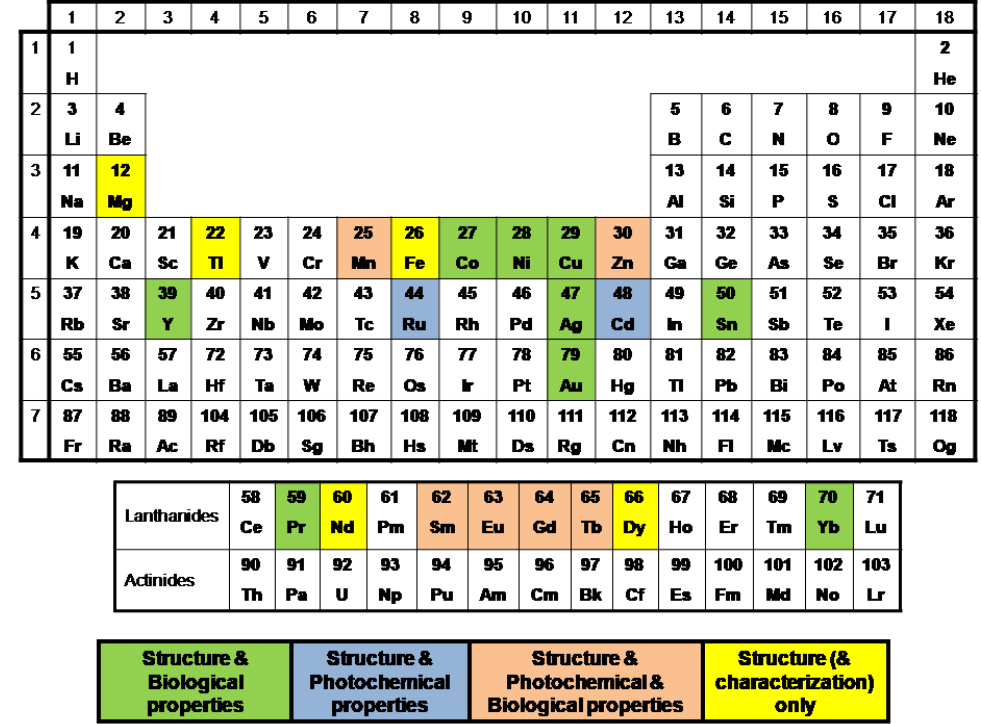
Figure 13. Periodic table of elements showing the metals participating in the coordination com- pounds with 1–naphthylacetato, 2–naphthylacetato, 1–pyreneacetato and naproxen ligands. (Color code: green = metal ions in characterized complexes studied for their biological properties; blue = metal ions in characterized complexes studied for their photochemical properties; orange = metal ions in characterized complexes studied for their photochemical and biological properties and yel- low = metal ions in characterized complexes without any further studies).